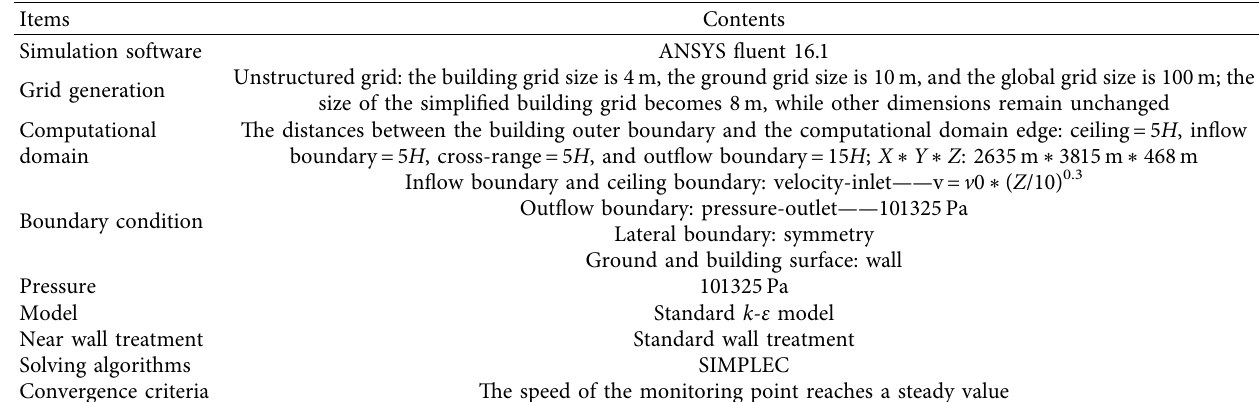
Table 10: The settings of various simulations in ANSYS